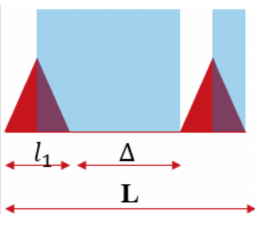
Figure 2. Two-dimensional model of